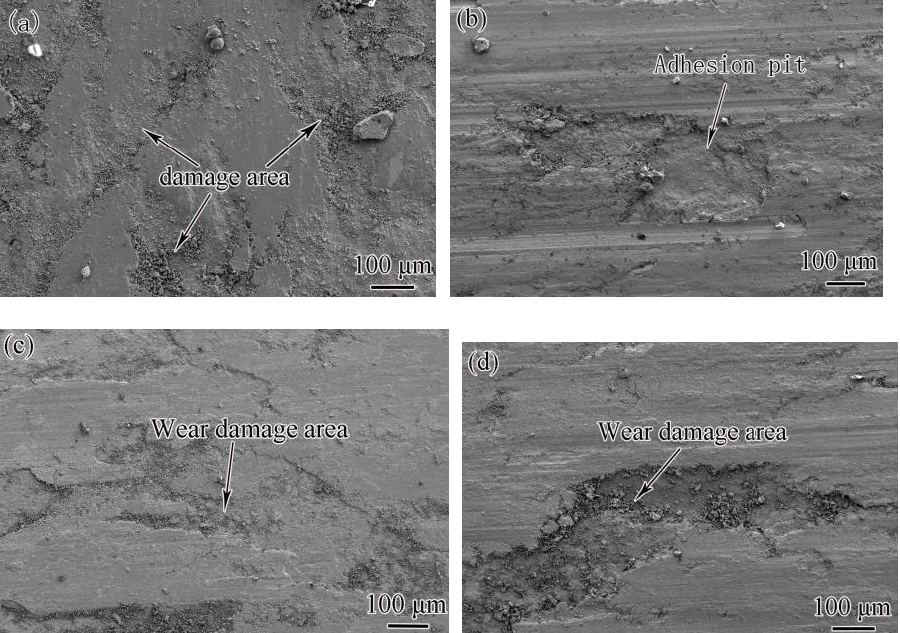
Figure 12. Wear morphologies of titanium alloy substrate and cladding layer under 50 N and 150 N